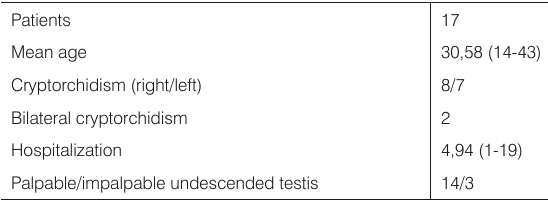
Table 1. Clinical characteristics of